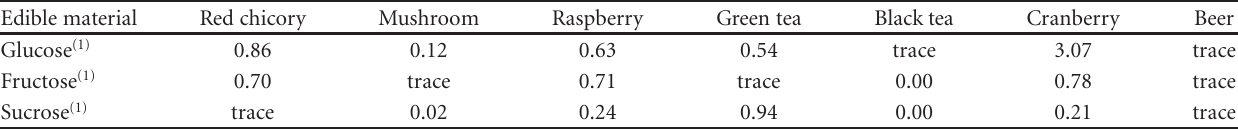
Table 2: Sucrose, glucose, and fructose content of the selected food/beverages (g/100g edible material).